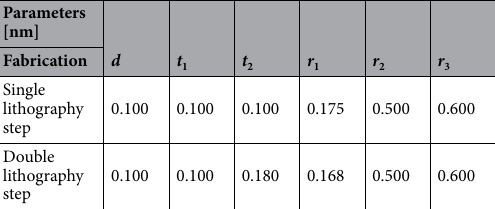
Table 1. Design parameters of the perfect absorber for different lithography methods. The period of disk a 0 is set to 1.34 μ m for both the